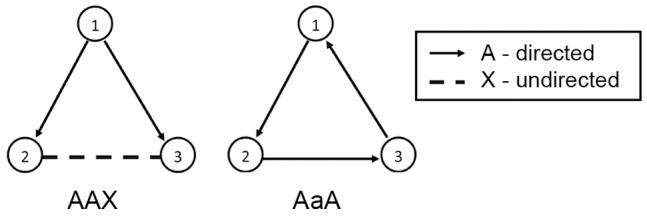
Examples of reflection and cyclic rotation symmetries.The motif on the left has a reflection symmetry between nodes 2 and 3. The motif on the right has a cyclic rotation symmetry between the three nodes.